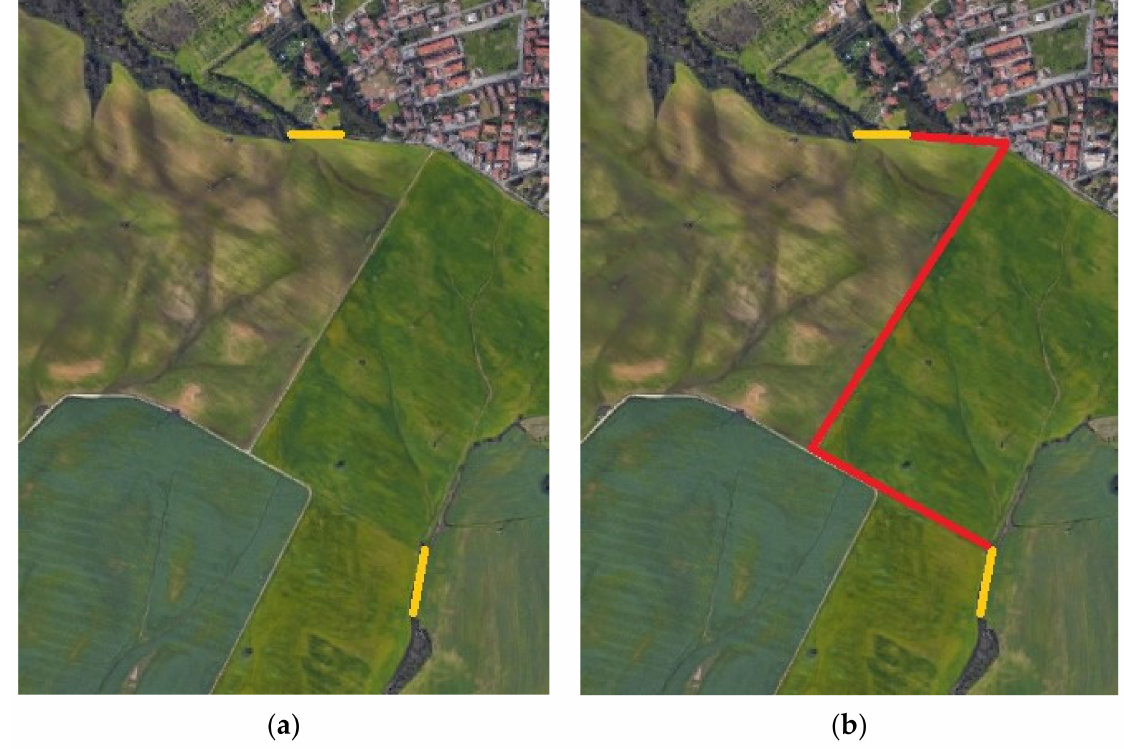
Figure 3. Simulated conversion of two branches ( a ) into a single bridge according to a pre-existing path ( b